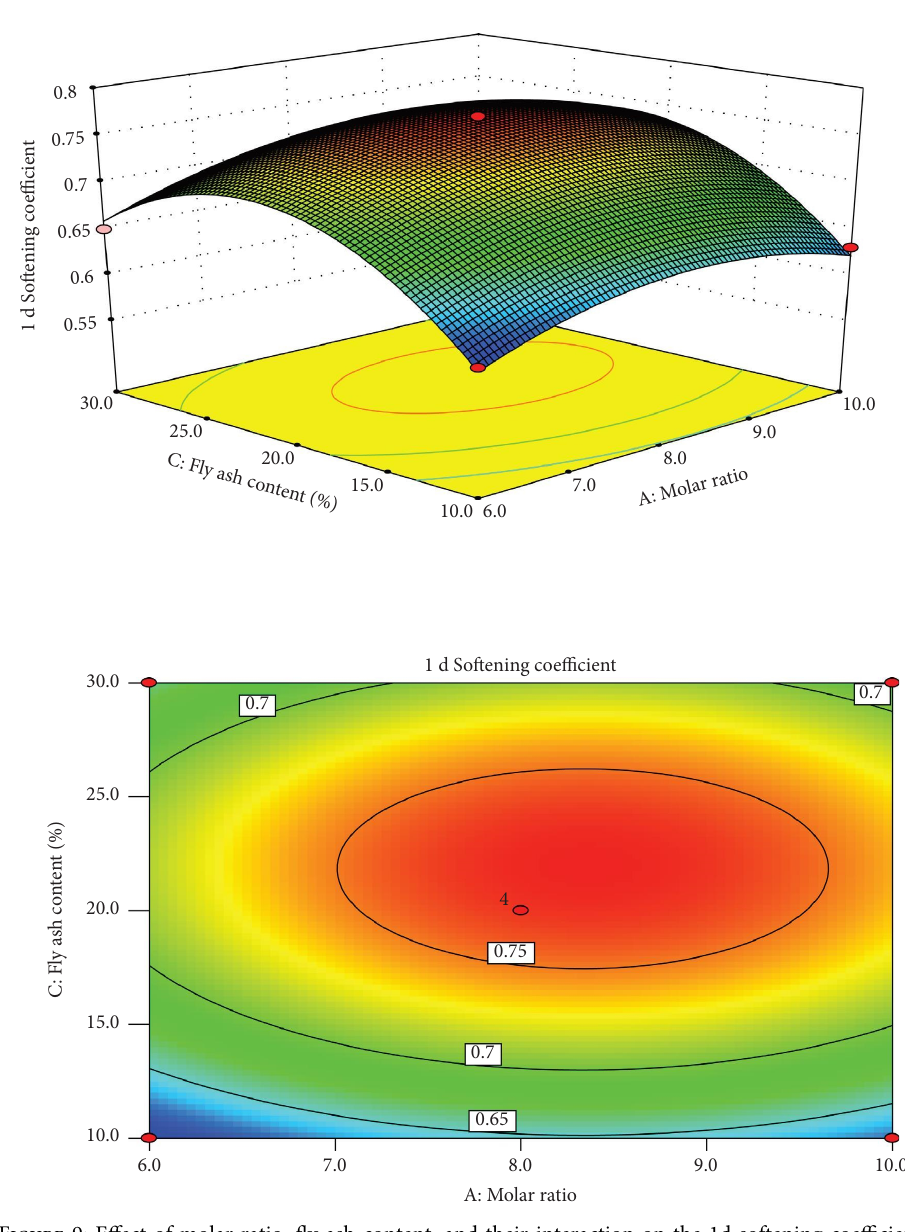
Figure 9: Efect of molar ratio, fy ash content, and their interaction on the 1d softening